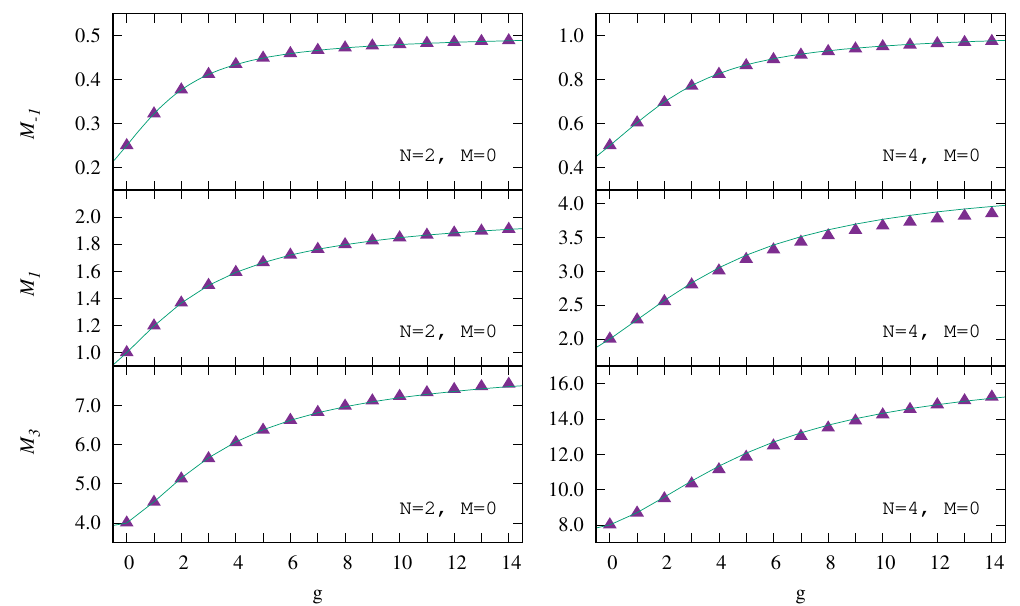
Figure 12. Values of the three energy momenta M − 1 , M 1 and M 3 for the cases of two and four particles as a function of the interaction strength. The calculations done using the explicit value of the dynamic structure function, Equation (57) are represented by dots and the line is the value computed using the sum rules, Equation (59). For M − 1 the results from Equations (59) and (60) are indistinguishable on the